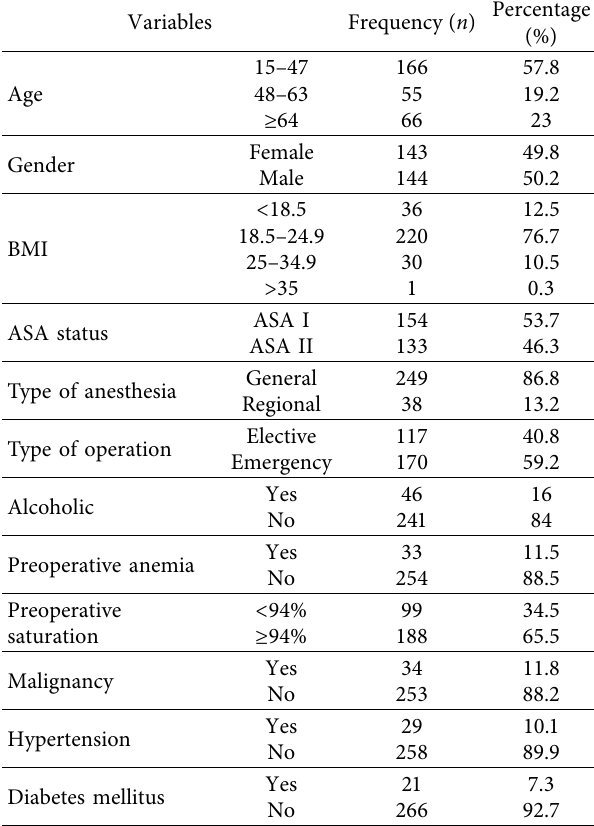
Table 1: The sociodemographic characteristics of patients who underwent abdominal surgery in public hospitals,